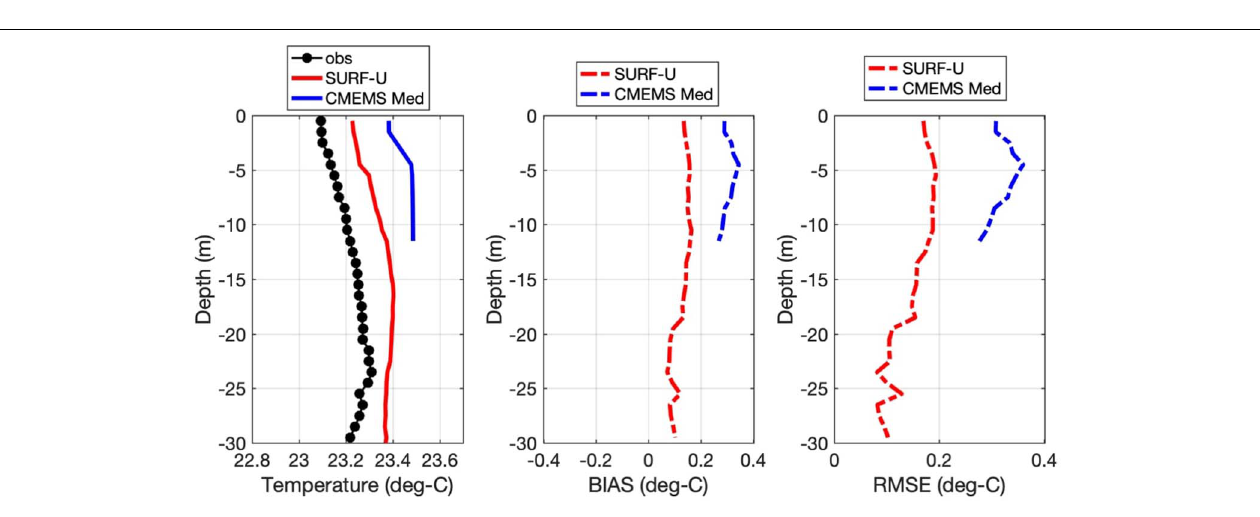
as represented by a single grid point located near the entrance of the Taranto Sea (see the black cross in the right panel of Figure 2